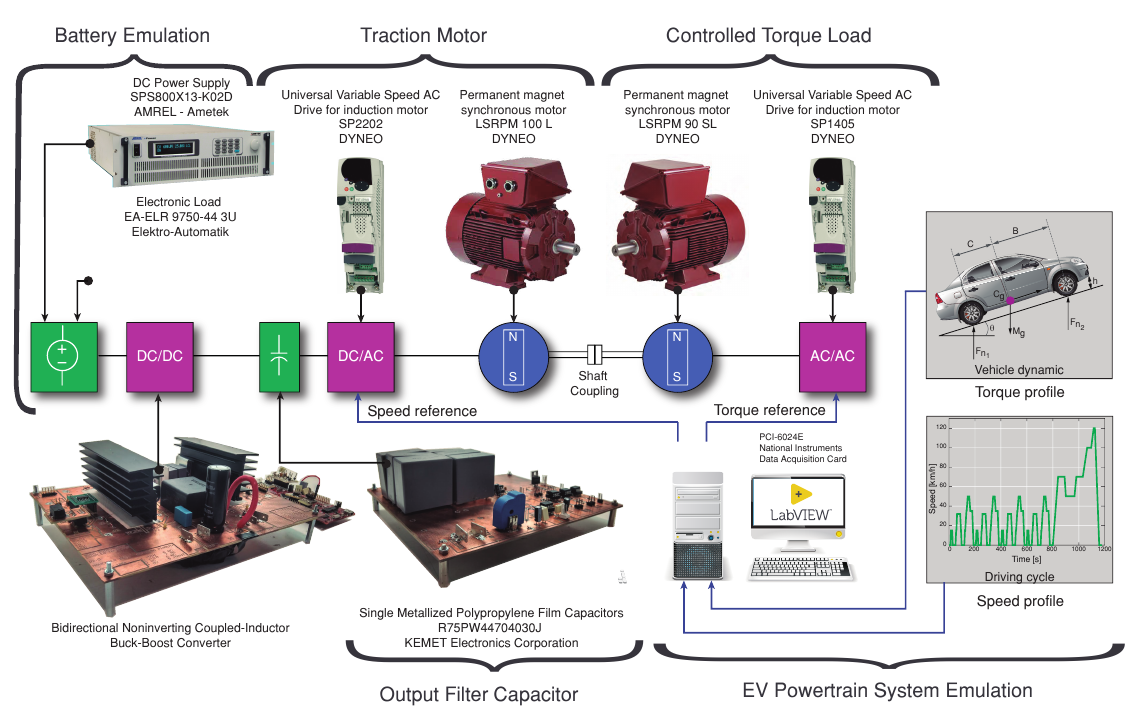
Figure 12. Diagram of the experimental setup: Converter dc-dc and EV powertrain.